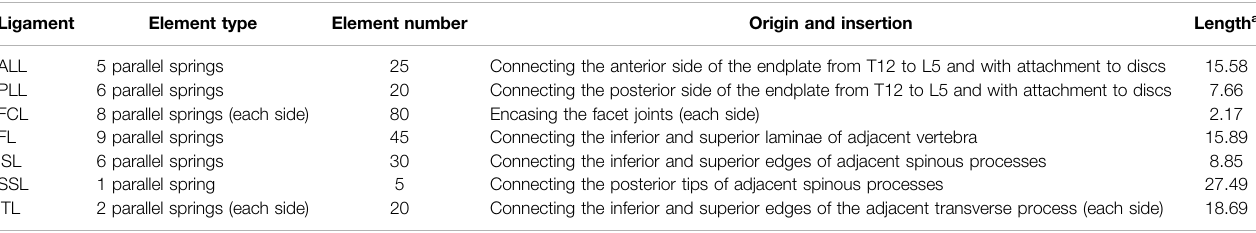
TABLE 2 | Details of ligaments in the intact model (Naserkhaki et al.,